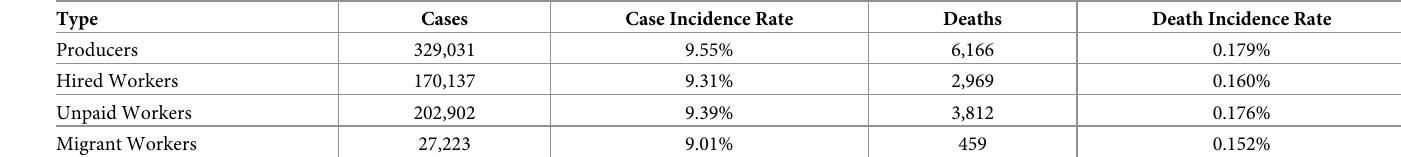
Table 1. Estimated number of cumulative cases and deaths from COVID-19 among types of agricultural workers as of March 31,